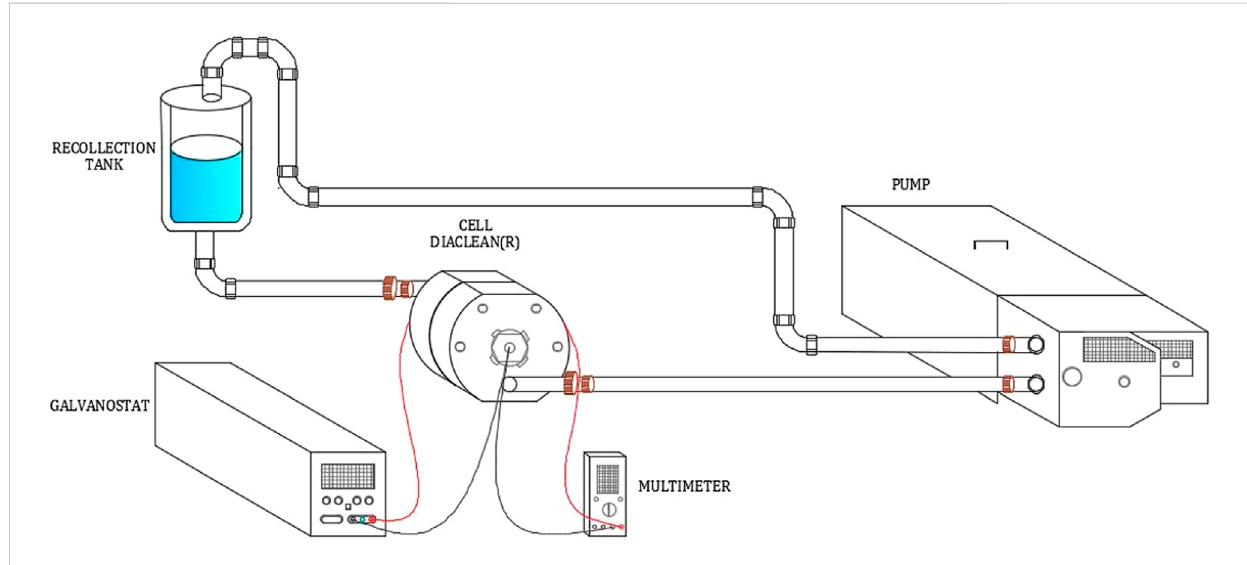
FIGURE 2 Experimental setup for the surfactant electrochemical